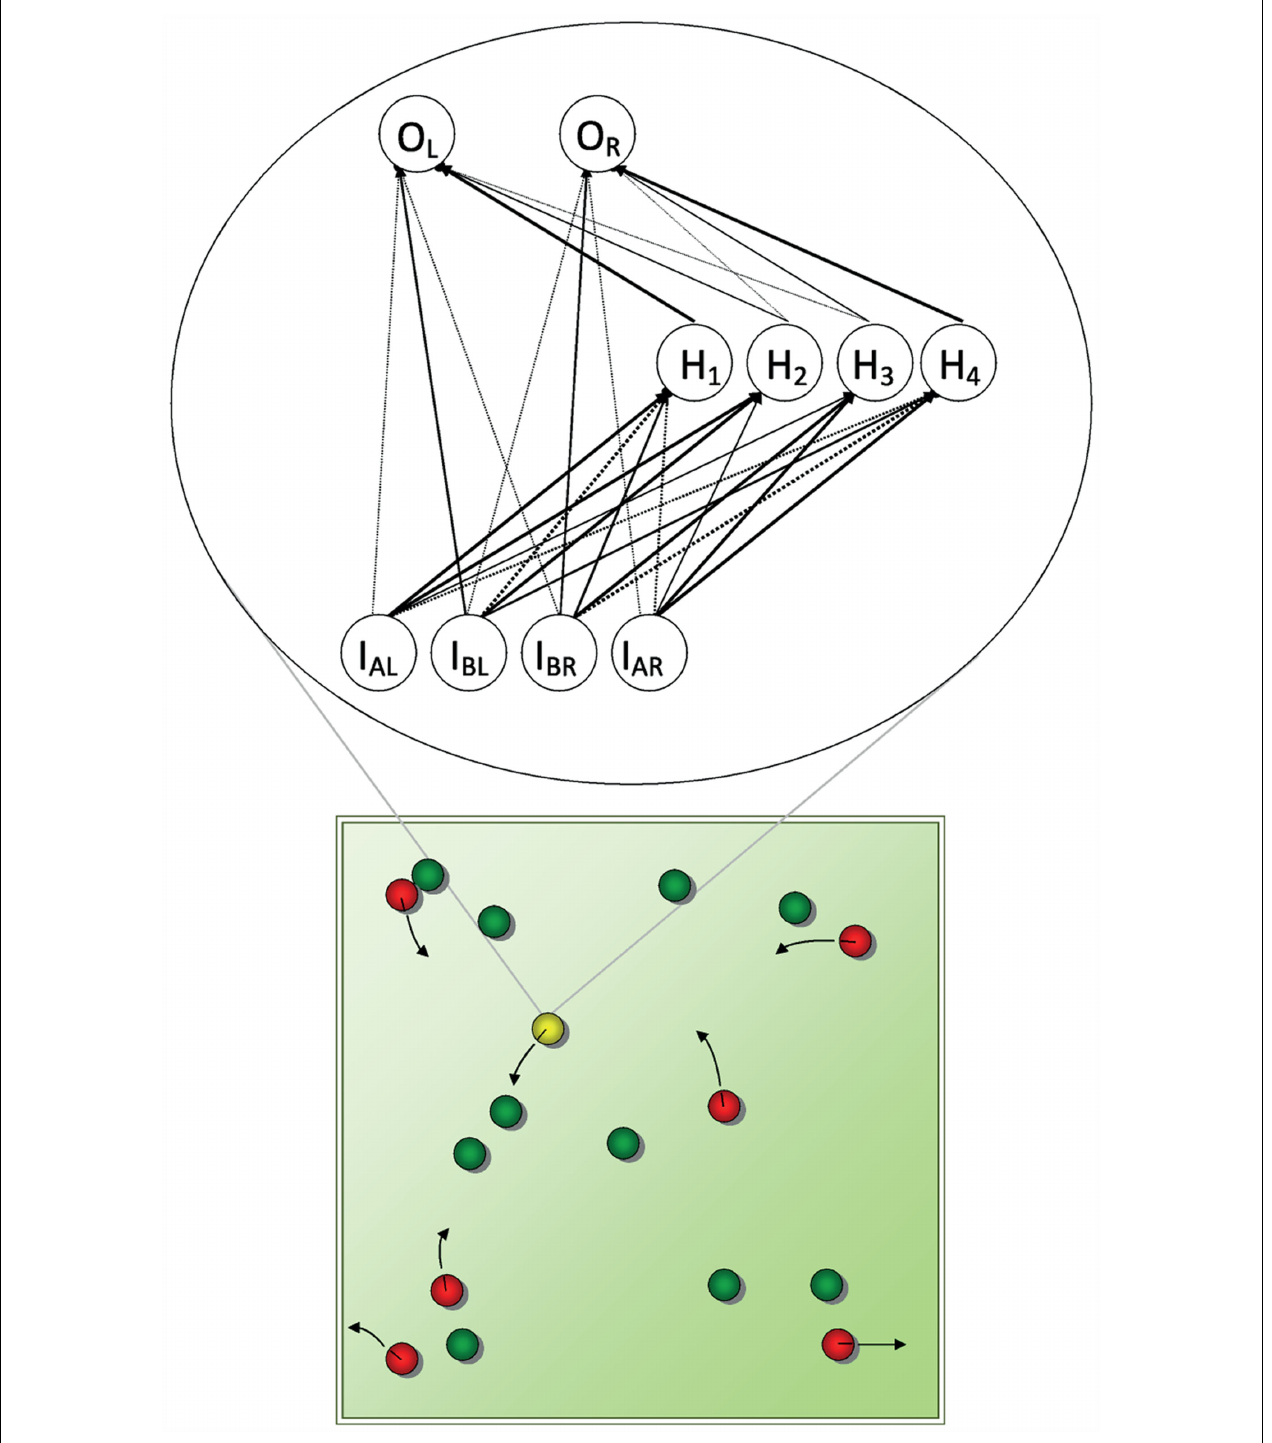
in the disappearance of the food patch.The predator is controlled by a fixed neural network, so that it moves toward the agent.The agent’s network (an example resulting from the den Dulk et al. simulations is shown at the inset) is subject to mutations and crossovers to its genes (i.e., the connection weights). Starting out with random connection strengths, eventually after hundreds of generations organized behavior (i.e., avoidance of predators, approach of food) emerges, due to the selection of the fittest agents for